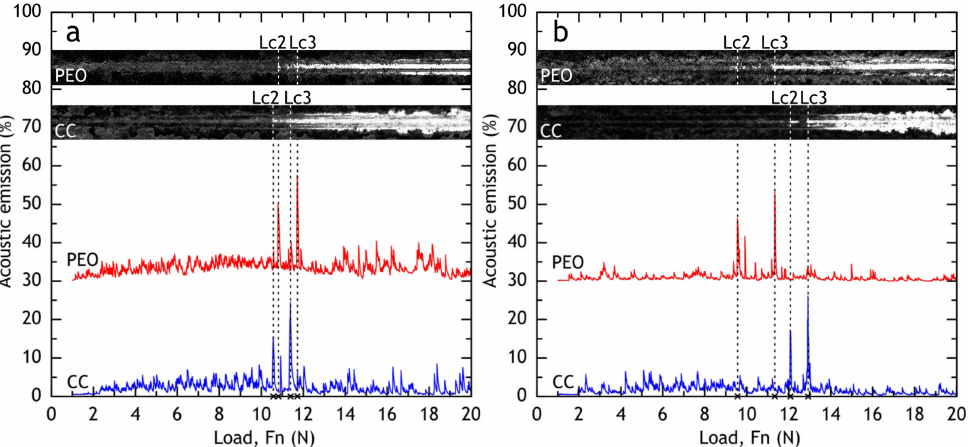
Figure 22. Micrograph of a full scratch, critical loads, and acoustic emission of PEO and composite coatings after 30 days of atmospheric exposure ( a ) and marine immersion ( b ).